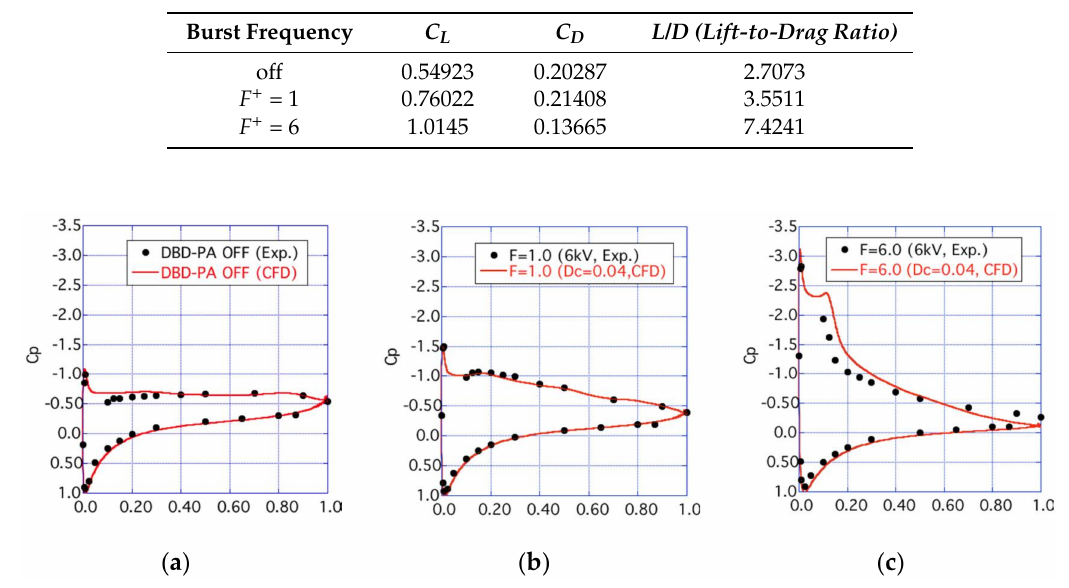
Figure 6. Chordwise C p distributions for NACA0015, α = 14 ◦ , BR = 10%, and Re = 6.3 × 10 4 (Experiment): ( a ) DBD-PA OFF; ( b ) DBD-PA ON: F + = 1.0; and ( c ) DBD-PA ON: F + = 6.0.